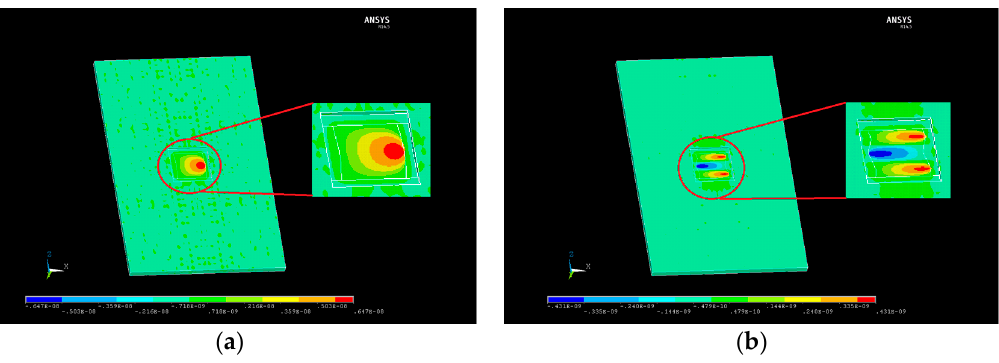
Figure 5. X -axis displacement patterns for the ( a ) fundamental thickness shear mode; and ( b ) first inharmonic mode.